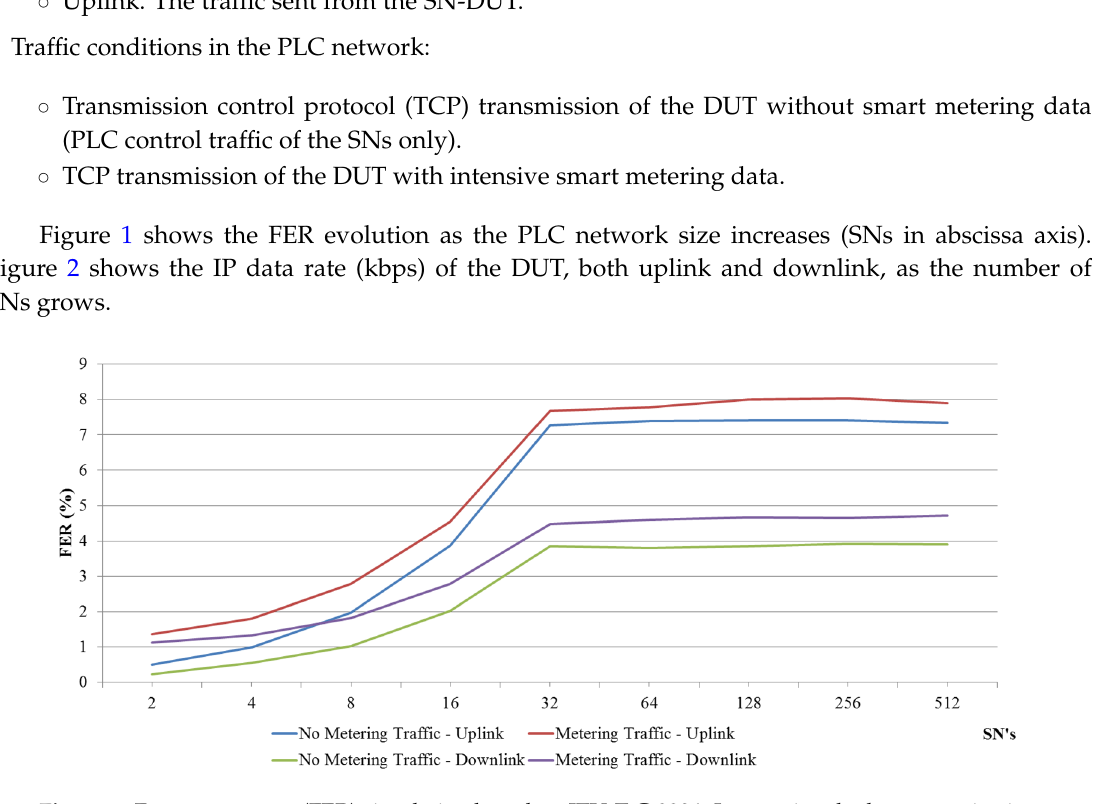
Figure 2. Data rate simulation based on ITU ‐ T G.9904. 5. Internet Protocol over narrowband high data rate Powerline Communications in CENELEC A ‐ Band ITU ‐ T G.9904 PLC builds a multiservice network designed to support multiple applications. Different convergence layers (CSs) are defined in order to optimize each data type transport over PLC.